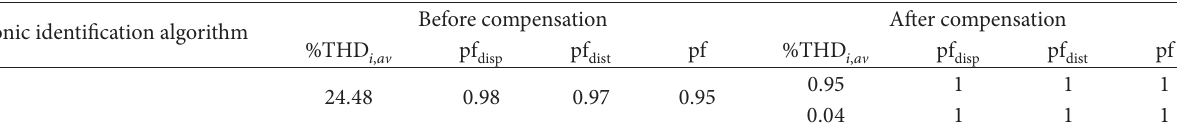
Figure 4: The flow chart of the SWFA approach. Table 1: The performance comparison between the PQ and PQF algorithms for balanced